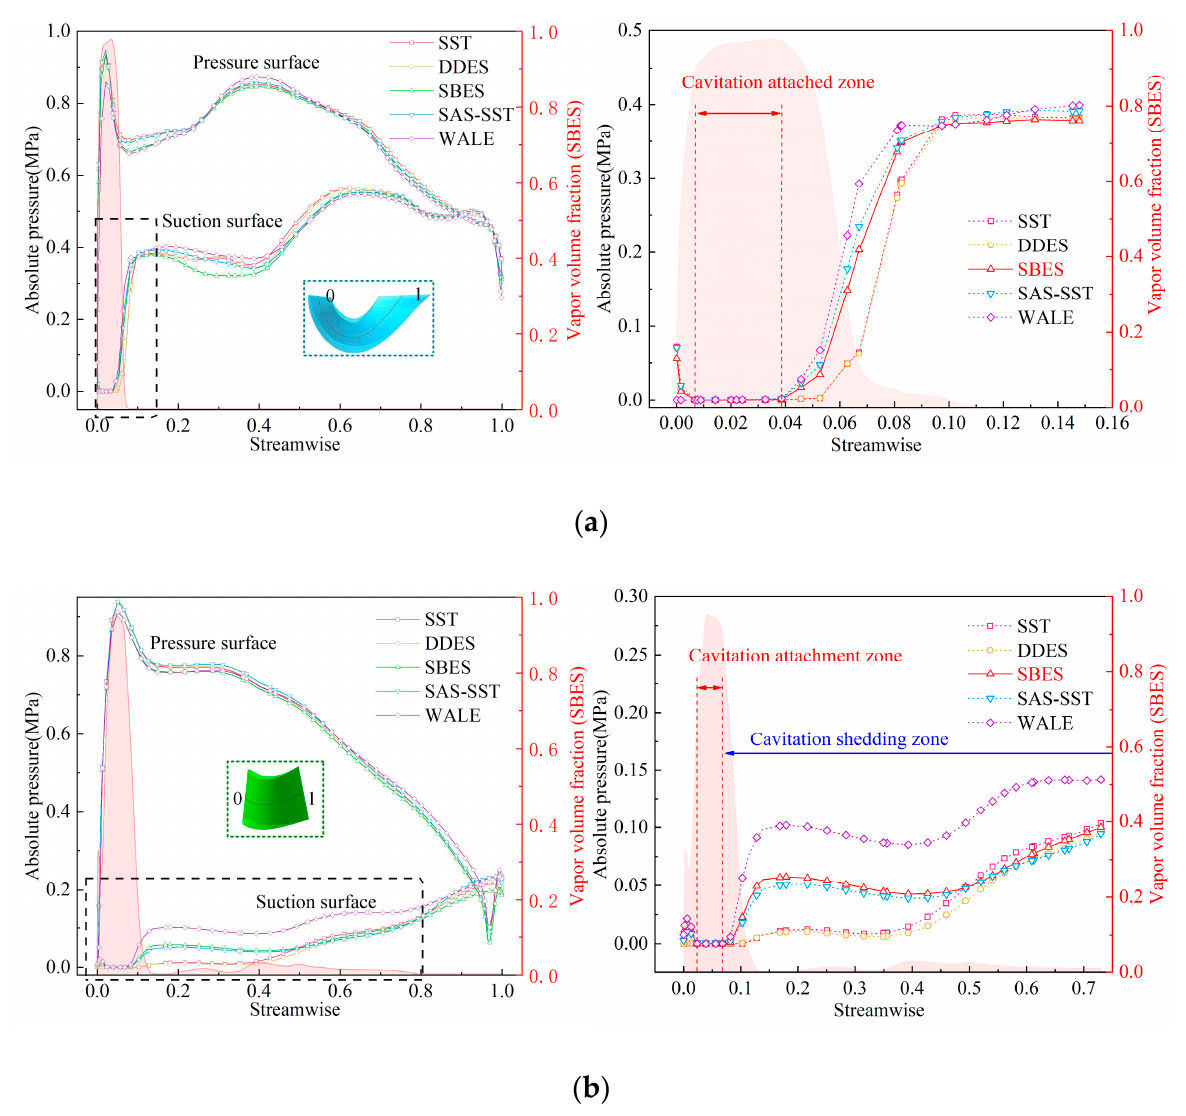
Figure 18. Absolute pressure distributions along the streamwise direction. ( a ) turbine blade, ( b ) stator blade.